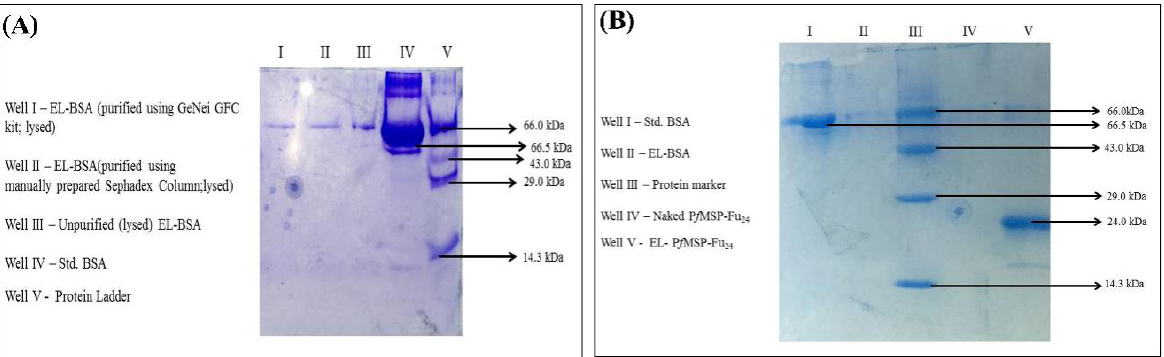
Figure 6. Assessment of in-process stability of different formulations by SDS-PAGE analysis for different formulation of plain and elastic liposomes loaded with ( A ) BSA and ( B ) EL- Pf MSP-Fu 24 . The bands were seen intact at 67 kDa (BSA) and 24 kDa ( Pf MSP-Fu 24 ).